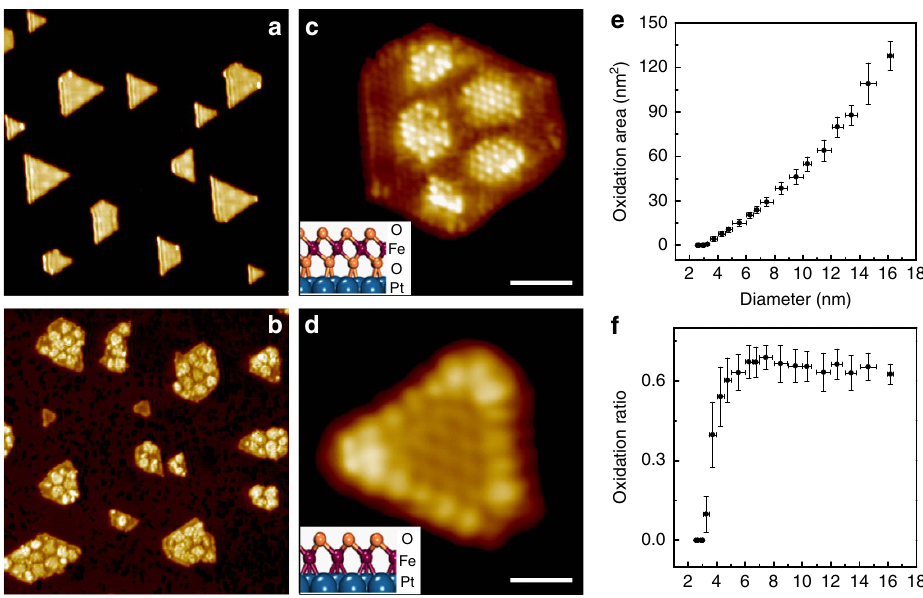
Figure 1 | The size-dependent oxidation kinetics of FeO nanostructures(NSs) on Pt(111). ( a , b ) STM images (50nm (cid:2) 50nm) of the typical surface of as-prepared FeO NSs on Pt(111) ( a ) and the FeO/Pt(111) surface after the annealing in 1 (cid:2) 10 (cid:3) 5 mbar O 2 at 500K for 10min ( b ). Most FeO NSs were oxidized to form FeO 2 domains, except for FeO NSs with an equivalent diameter d o 3.2nm. Here, the FeO NS is treated as a circle and the equivalent diameter is defined as d ¼ 2 (cid:2) ffiffiffiffiffiffiffiffi S = p p , where S is the NS surface area. ( c , d ) Atomic STM images of an oxidized FeO NS ( d ¼ 6.2nm) with the formation of FeO 2 domains and an FeO NS ( d ¼ 2.1nm) remaining the FeO phase, respectively. The structural models (side view) of FeO 2 and FeO on Pt(111) are shown in the insets. STM images were taken at 230K and scanning parameters (sample bias: V s ; tunneling current: I t ) are ( c ) V s ¼ þ 104mV, I t ¼ 3.5nA; ( d ) V s ¼ þ 53mV, I t ¼ 2.1nA. Scale bars are 2nm in c and 1nm in d . The area of FeO 2 domains ( S FeO2 ) on each NS, as well as the NS surface area ( S ), are measured over 247 FeO islands on the same surface. ( e , f ) plot the oxidation area ( S FeO2 ) and the oxidation ratio ( S FeO2 / S ) of individual FeO NSs as a function of d , where the size range of FeO NSs and the s.d. of S FeO2 and S FeO2 / S are represented by error bars.